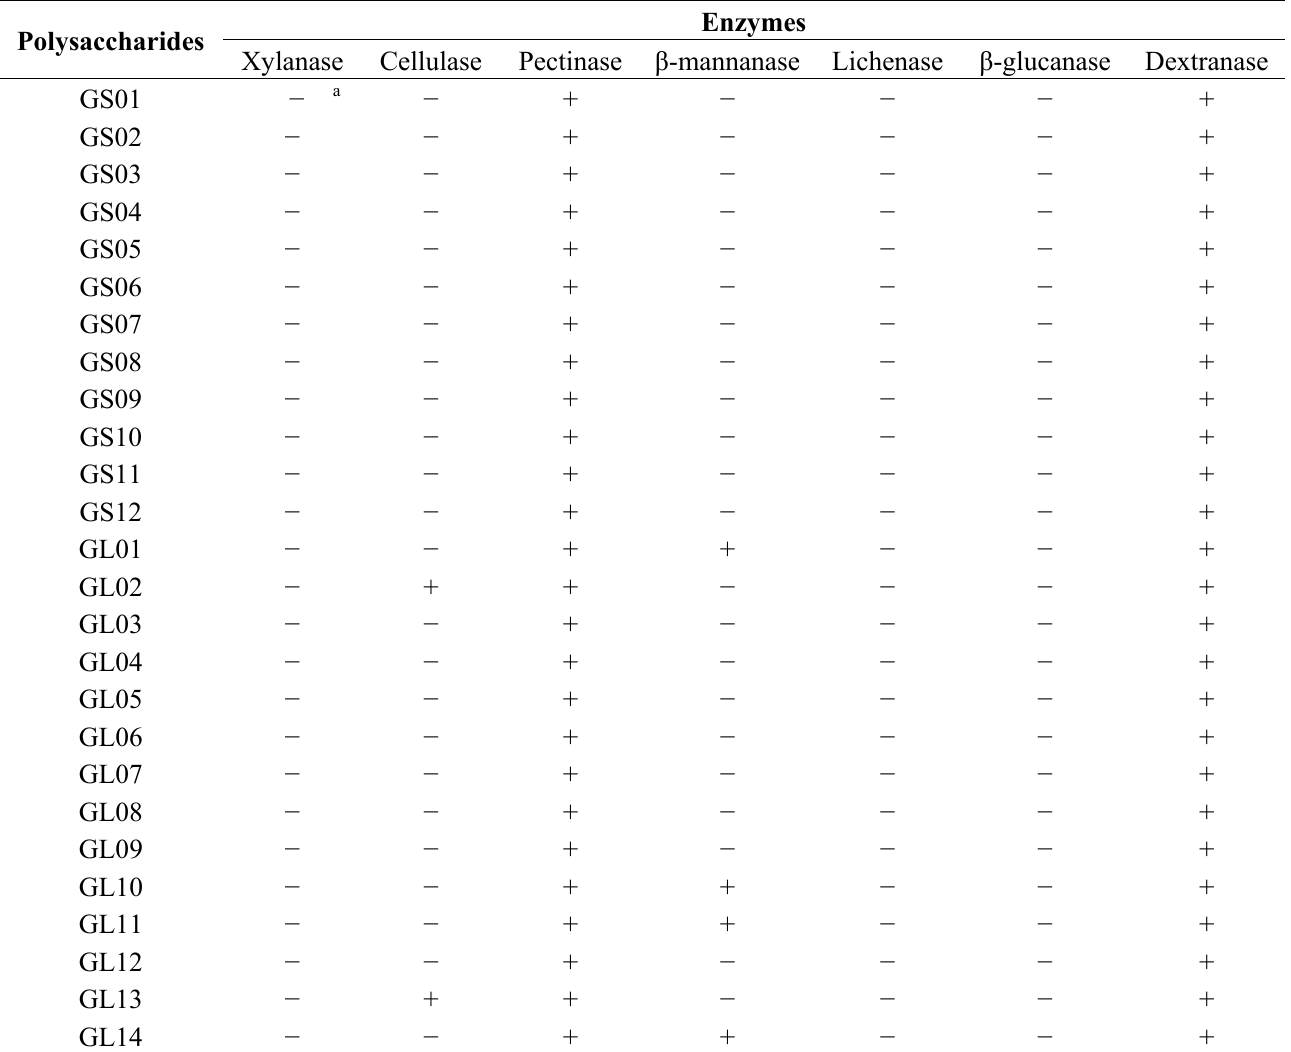
Table 1. Responses of polysaccharides from Lingzhi to enzymatic digestion.